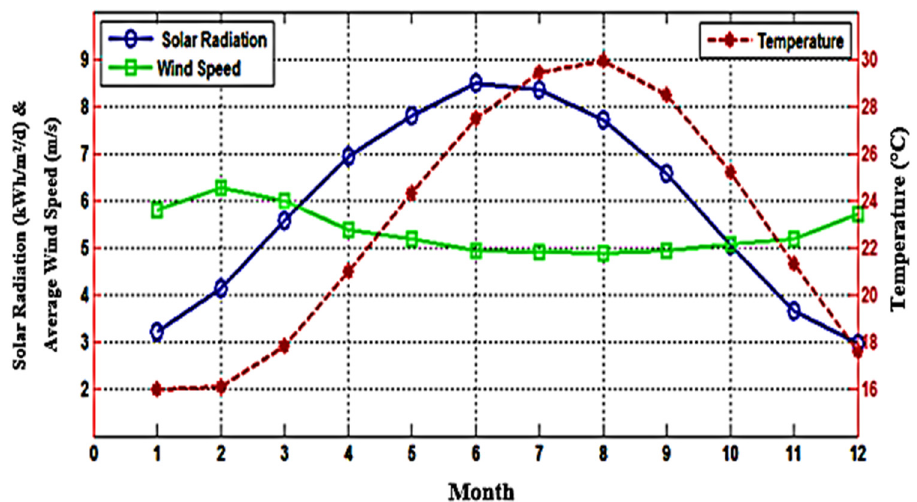
Figure 4. The average monthly solar radiation, wind speed and earth’s surface temperature data in Alexandria, Egypt.